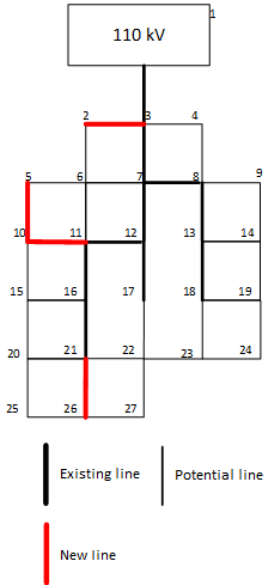
Figure A8. New lines for scenario “4”.